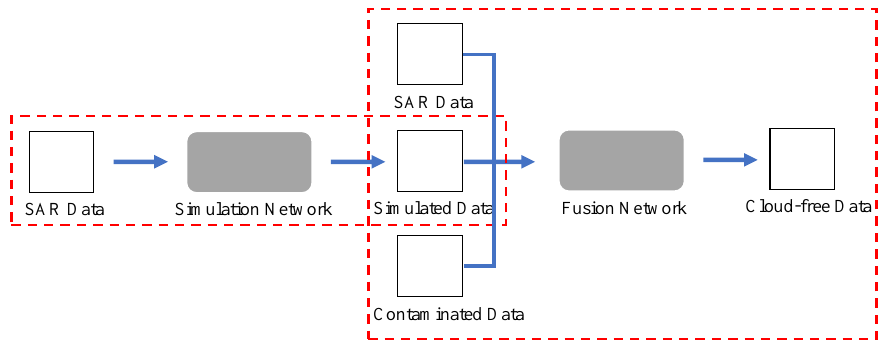
Figure 7. The flowchart of typical Hybrid